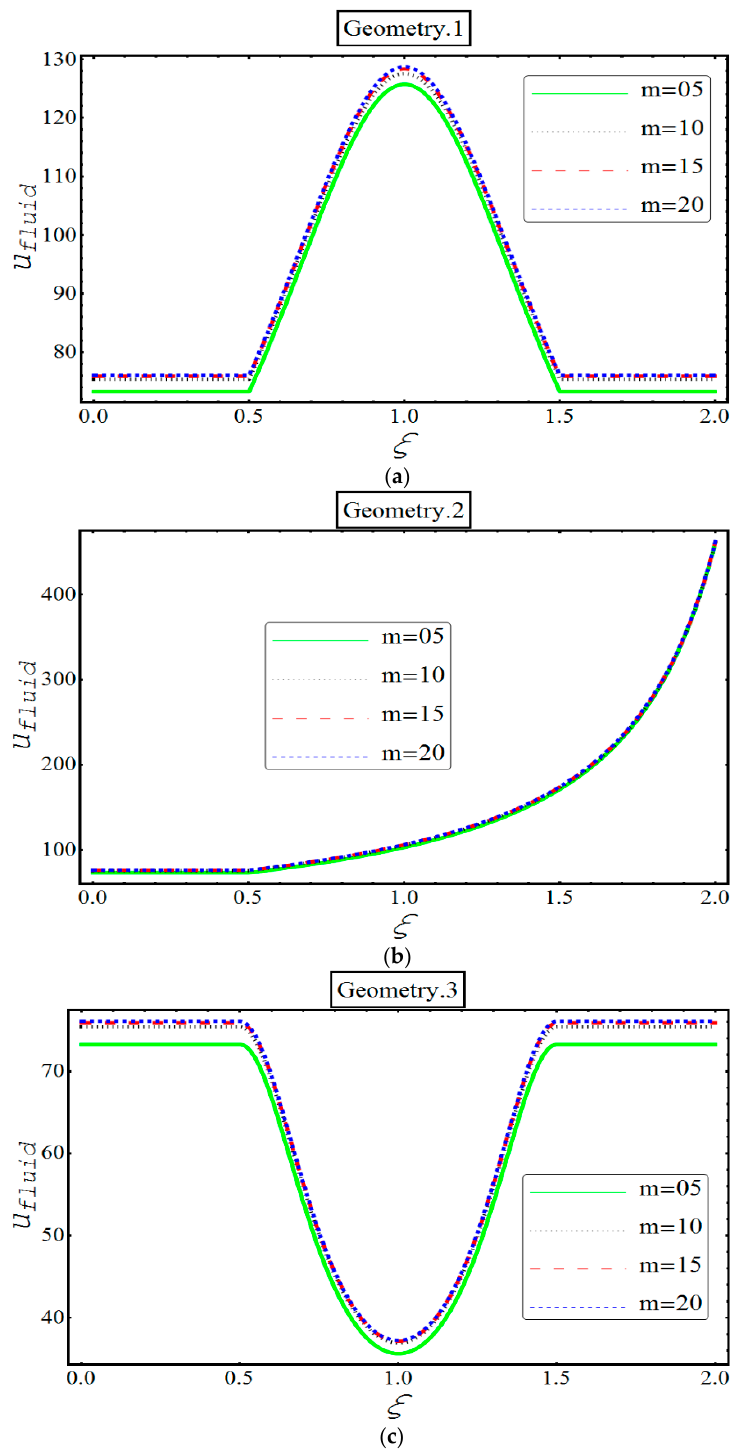
Figure 6. Variation of the velocity (cid:1873) (cid:3033) for various electro-osmotic parameters.